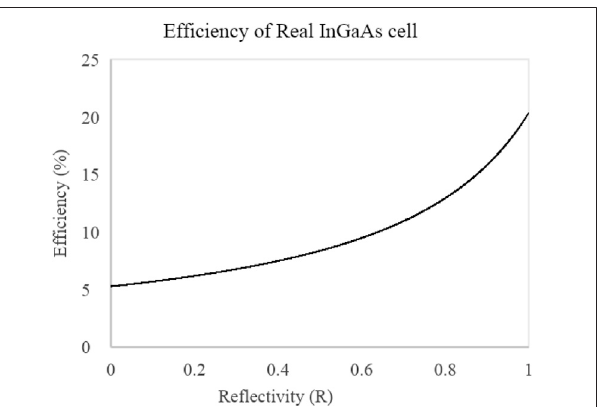
region is the emissive intensity, having energy above the bandgap energy (0.74 eV) for an InGaAs TPV cell.